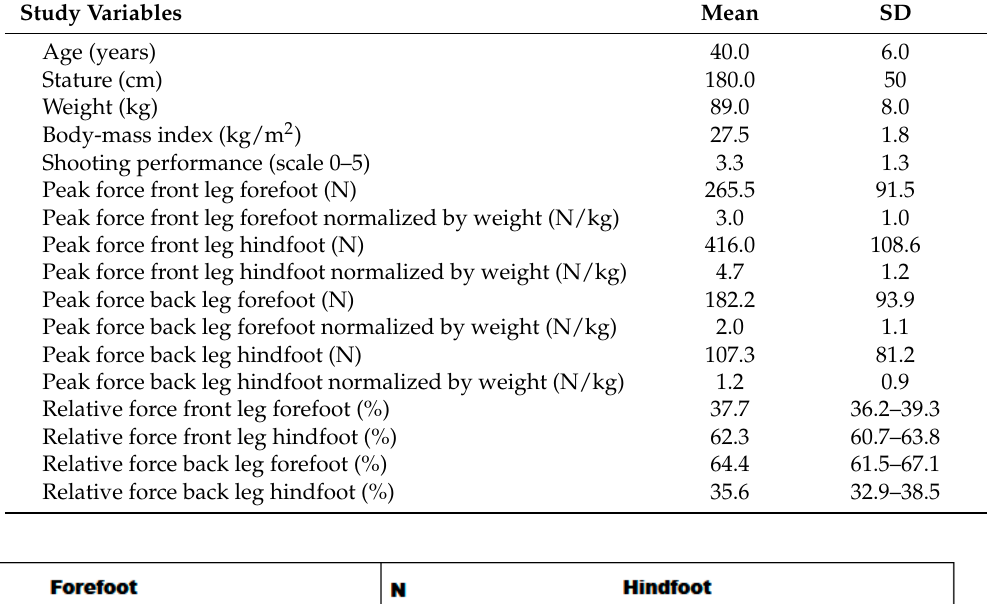
Table 1. Basic descriptive statistics of the study participants ( N = 30).